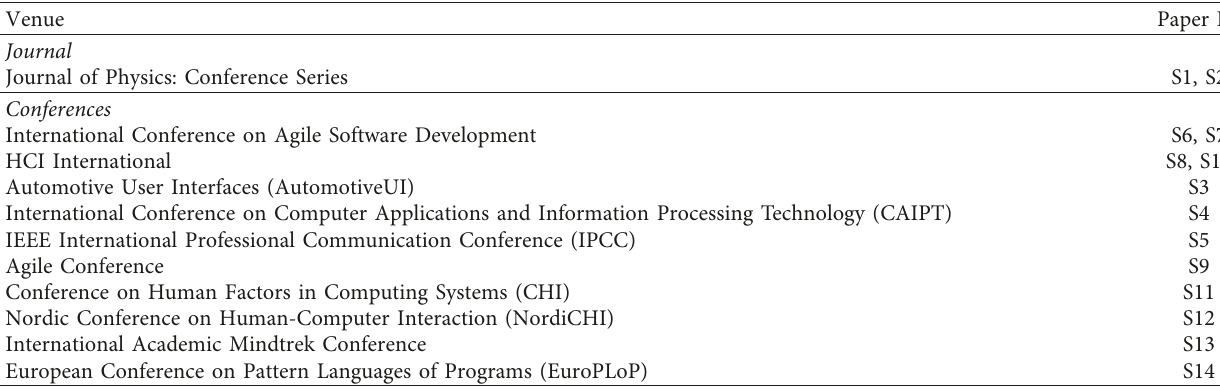
Figure 3: Time view of the extracted Table 4: Publication venues of the extracted papers.